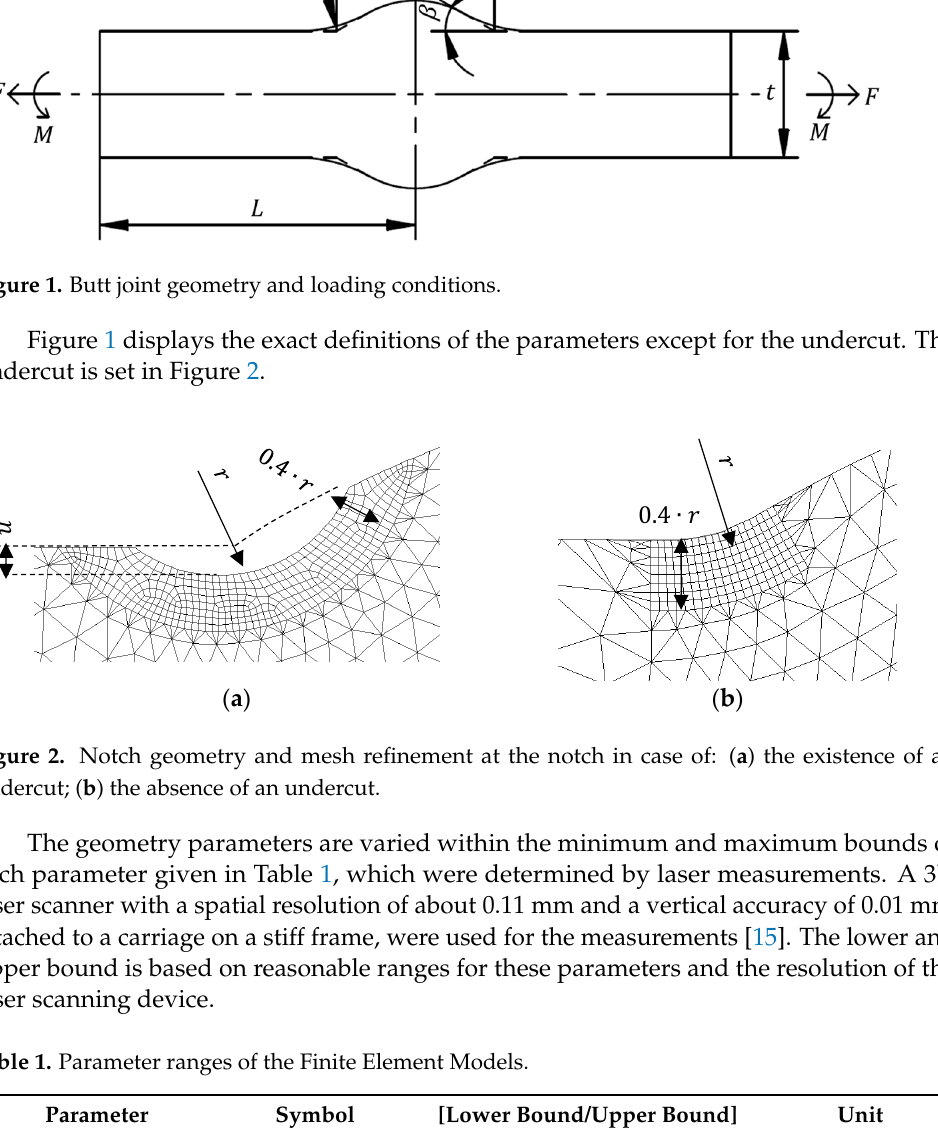
Table 1. Parameter ranges of the Finite Element Models.